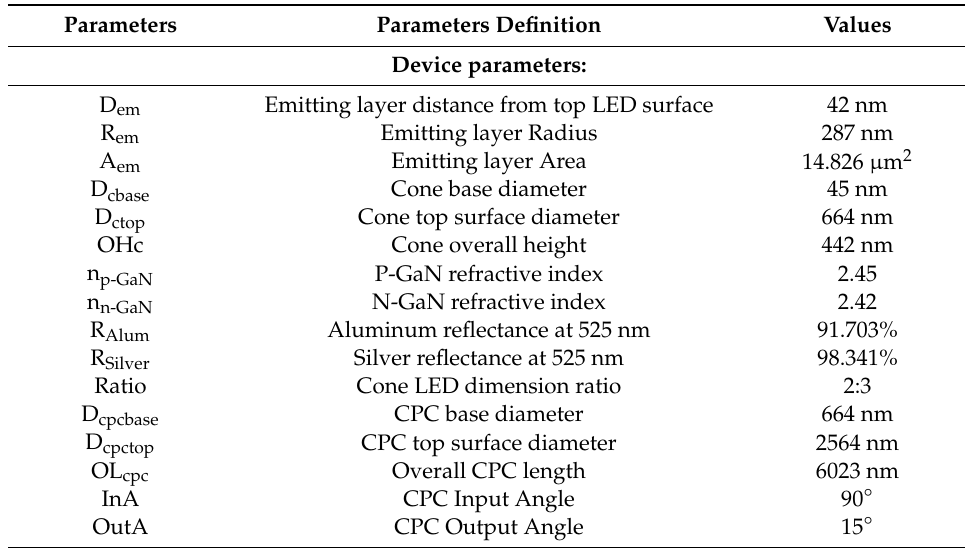
Table 1. LENS parameters using LightTools